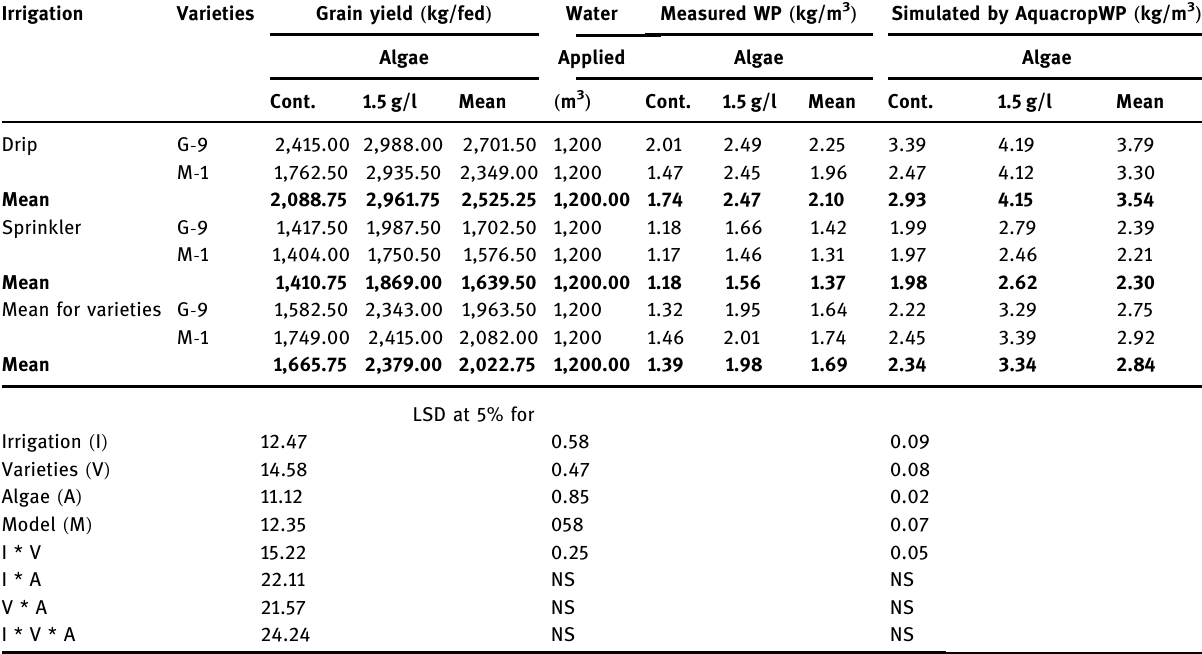
Table 2: E ff ect of the irrigation systems, wheat cultivars and algae on the observed and simulated water productivity Irrigation